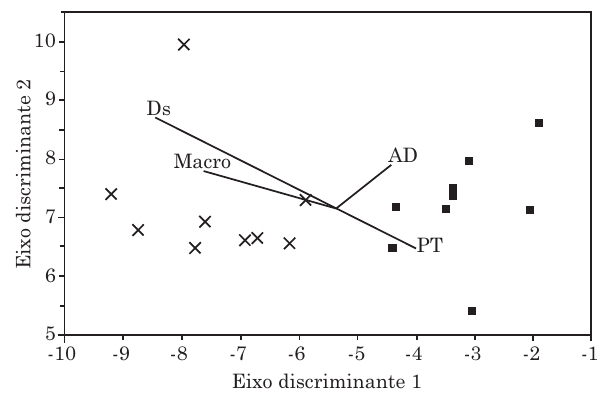
Figura 3. Análise discriminante de Fischer com base nos atributos físicos selecionados pela análise de componentes principais dos horizontes BAx de solos coesos do segmento superior (×) e inferior ( nnnnn ) (n = 9 em cada posição) de topossequência no município de Itaboraí, RJ. Ds: densidade do solo, AD: água disponível, PT: porosidade total e Macro: